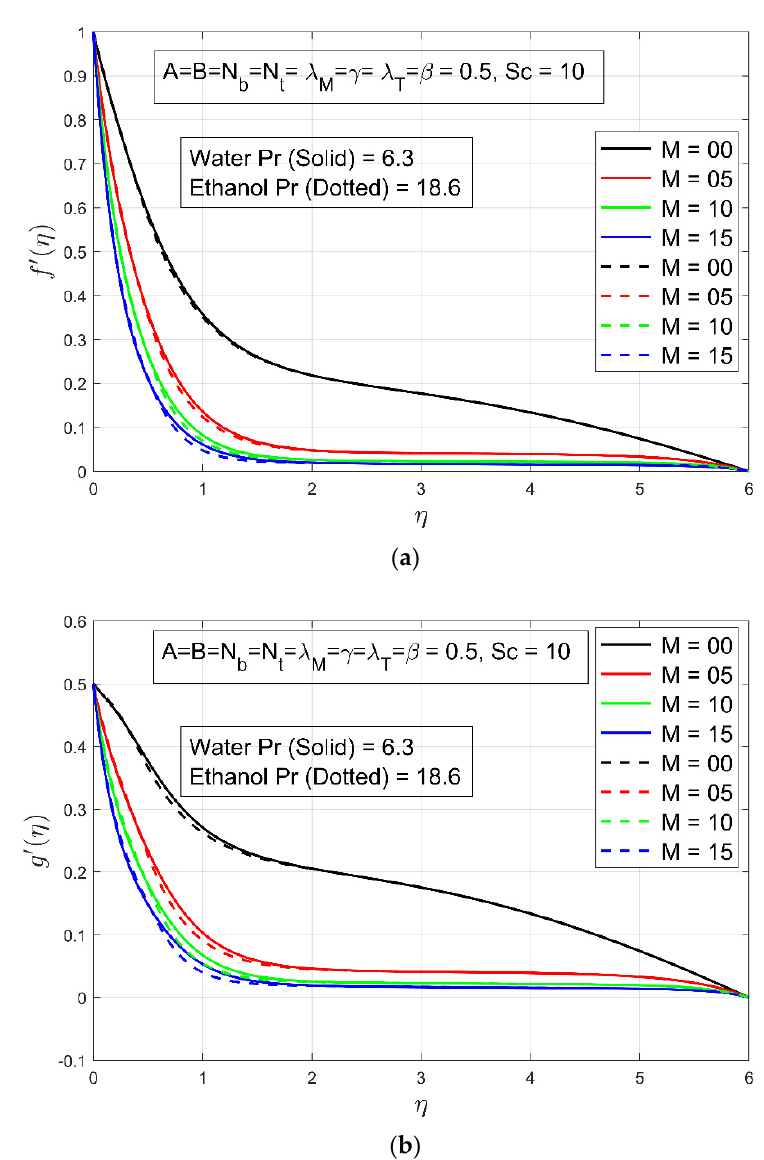
Figure 2. ( a ) The effect of M on the velocity profile f (cid:4593) (η) ; ( b ) The effect of M on the velocity profile g (cid:4593) (η) .